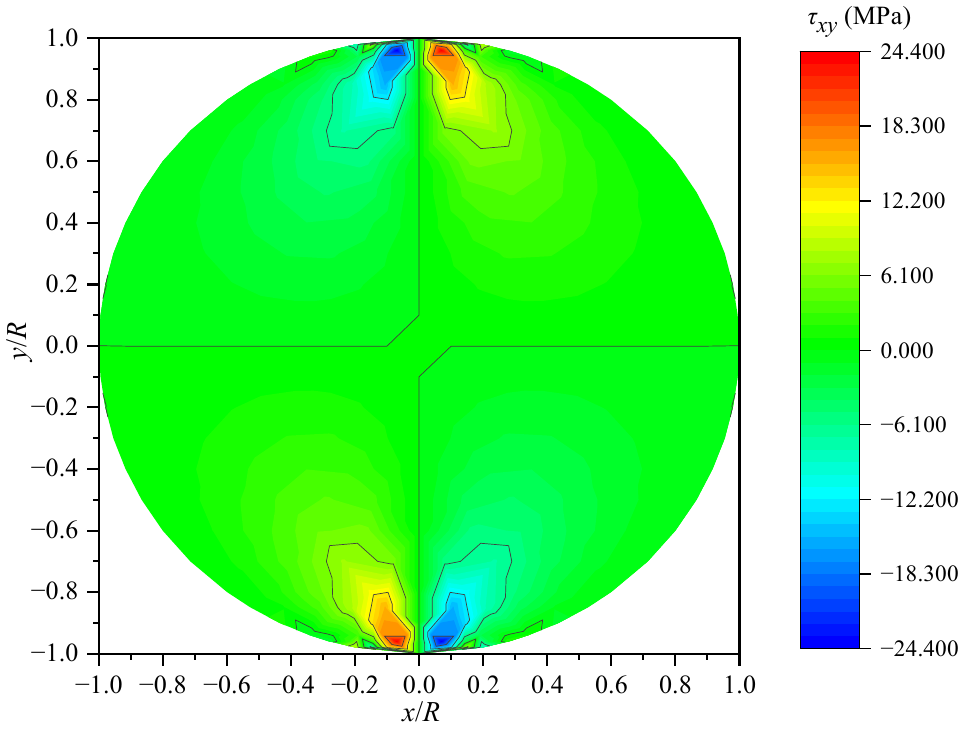
Figure 6. τ xy contour map of the axial compression on the part boundary of the circular shaft. Table 1. The stresses σ x (MPa) and σ y (MPa) at points ( x = 0 and y dm) of the axial compression on the part boundary of the circular shaft.